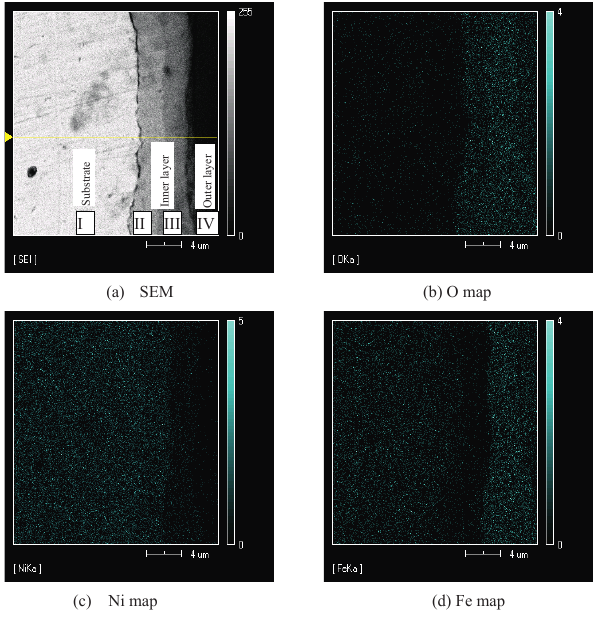
Figure 3. Cross-sectional morphology of oxide scale of 20Fe-80Ni oxidized at 700 ı C.